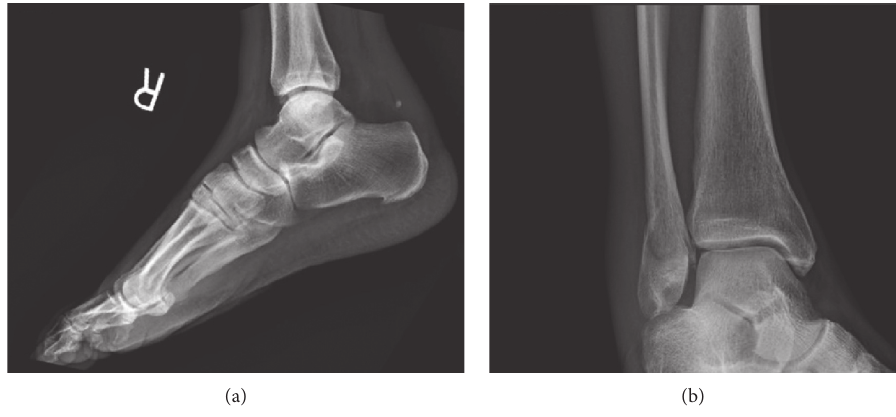
Figure 1: Plain radiographs: (a) lateral view and (b) mortise view.